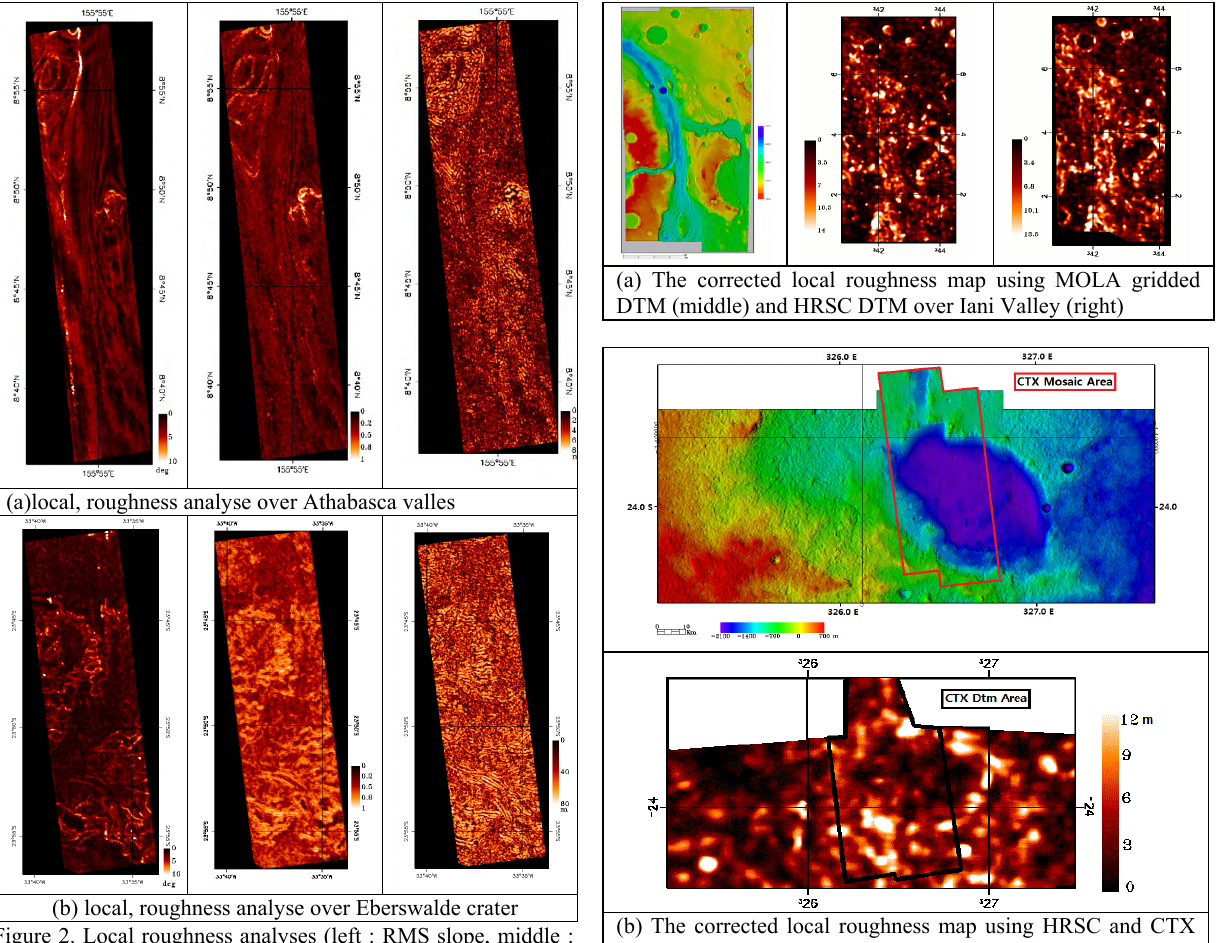
Figure 2. Local roughness analyses (left : RMS slope, middle : Hurst constant, right : autocorrelation length)